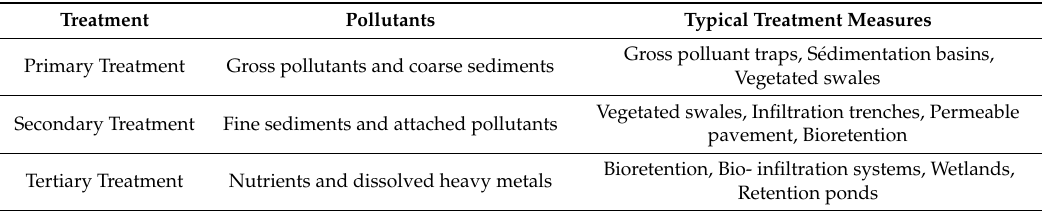
Table 4. GI Treatment Measures in GI Treatment Trains